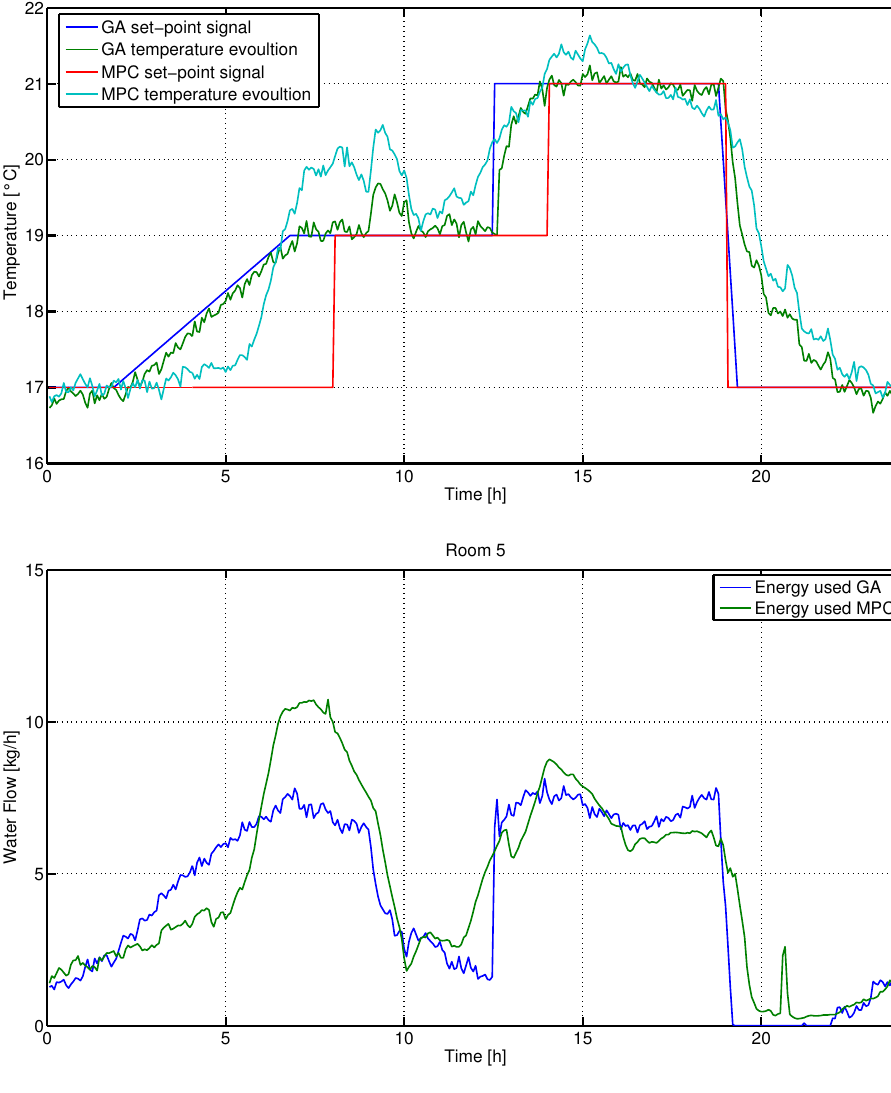
Figure 15. One day simulation, 10 December, for room 5 (ARMAX model). Top : user defined set point ˜ T i (red line), optimized set-point ramp signal ¯ T i (blue line), temperature evolution T i in case of genetic algorithm set-point signal (green line), temperature evolution T i in case of MPC (light blue line). Bottom : resulting inlet water flow in case of ramp set-point signal (blue line) and in case of MPC (green